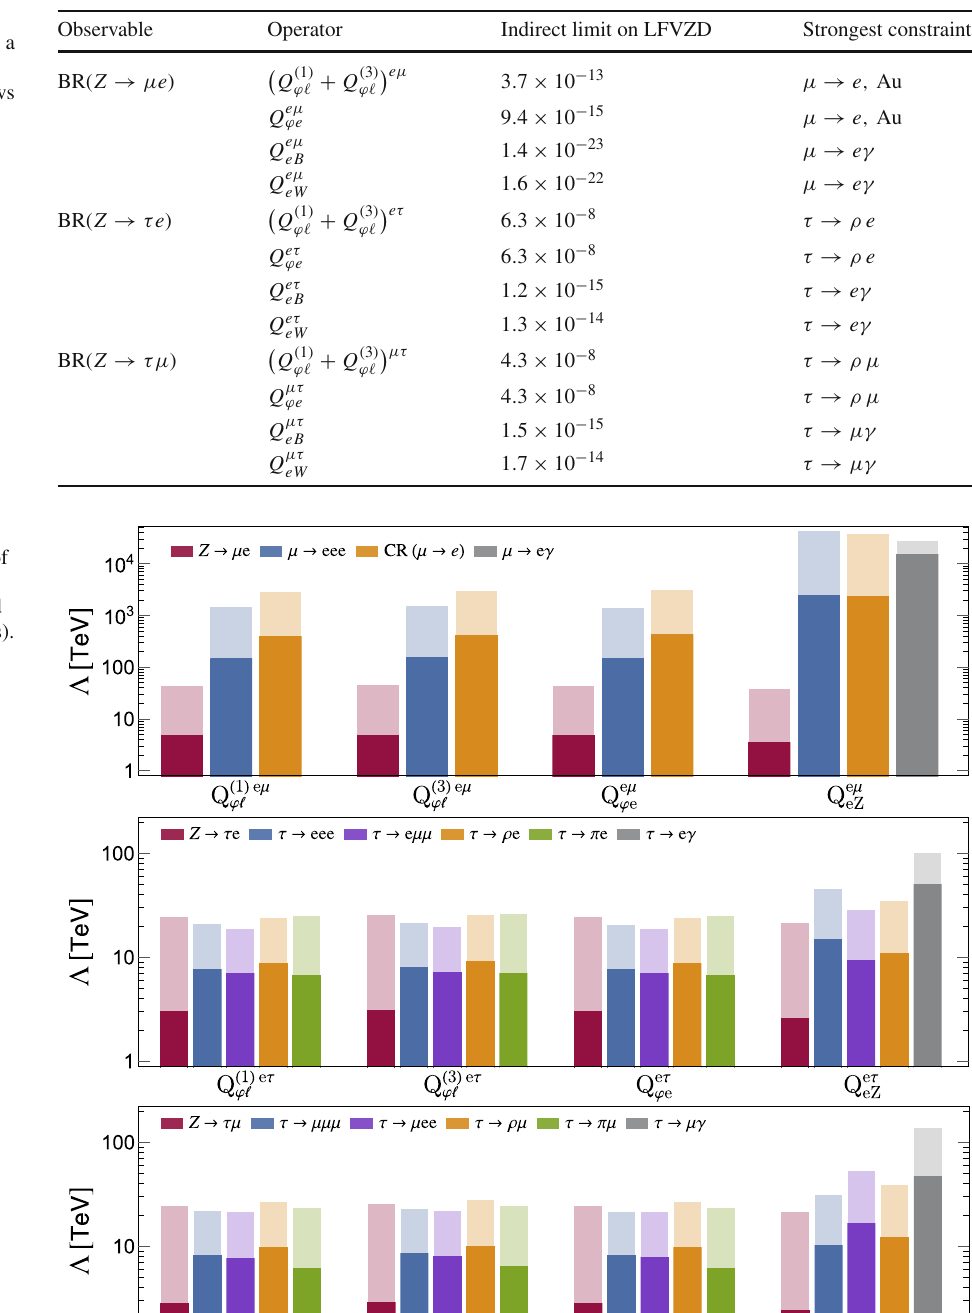
Fig. 2 Values of the NP scale (cid:6) that are accessible by each of the LFV observables with current bounds (solid bars) and future sensitivities (lighter bars). We assume that C ((cid:6)) ≤ 1 for each operator at a time, while the others vanish at μ =